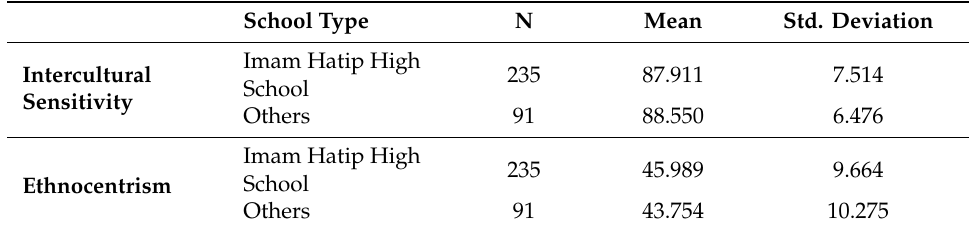
Table 13. Mean and standard deviation of students’ scores by the type of high school they graduated from in the Intercultural Sensitivity Scale and the Ethnocentrism Scale.